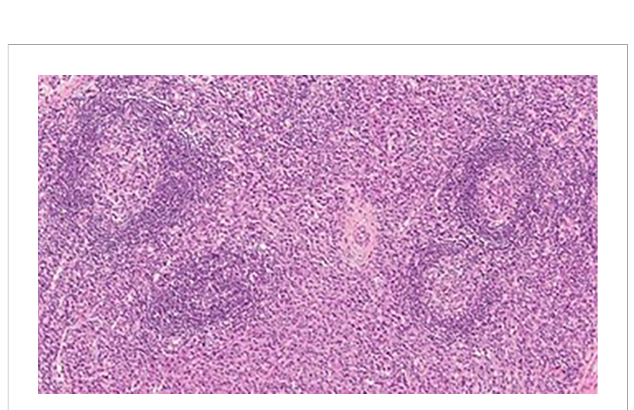
FIGURE 3 CD plasma cell type: numerous hyperplastic follicles with “ onion skin ” pattern in the mantle zone. The interfollicular area is almost exclusively composed of plasma cell in fi